Question: Is the quantity shown trending increasing or decreasing?
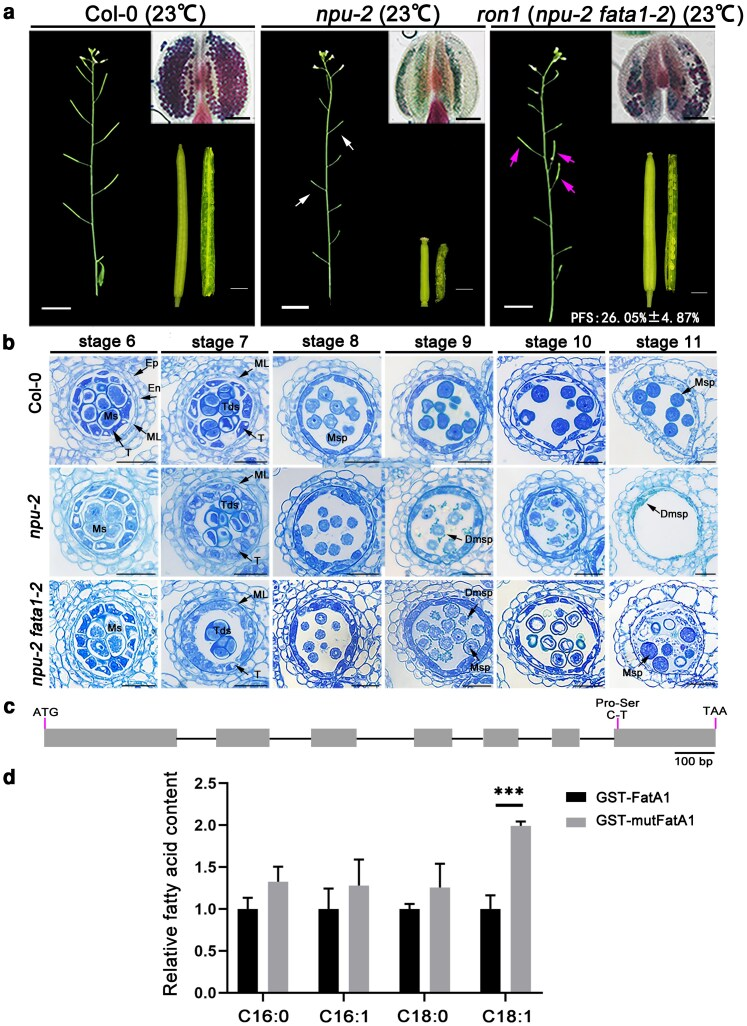
Answer: increasing